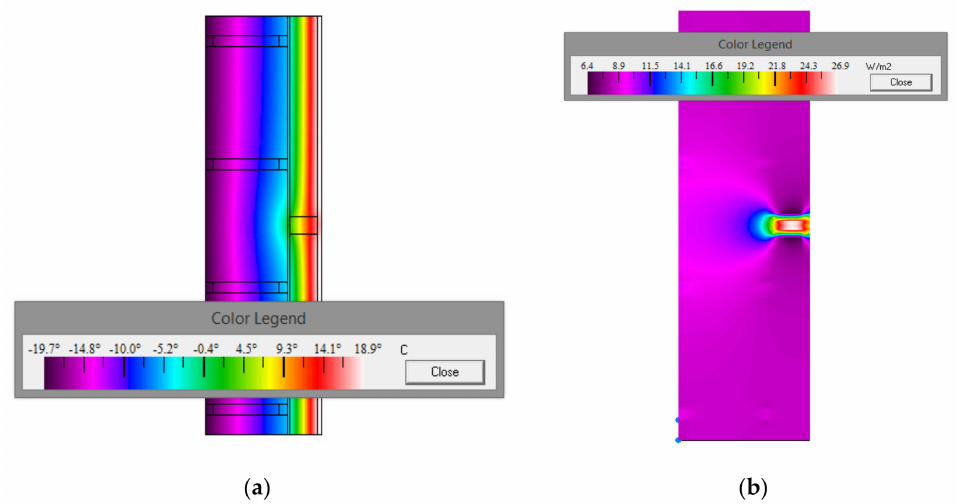
Figure 16. Comparison of calculation results for a wall made from horizontal logs without thermal insulation ( a —isotherm layout, b —heat stream density distribution).